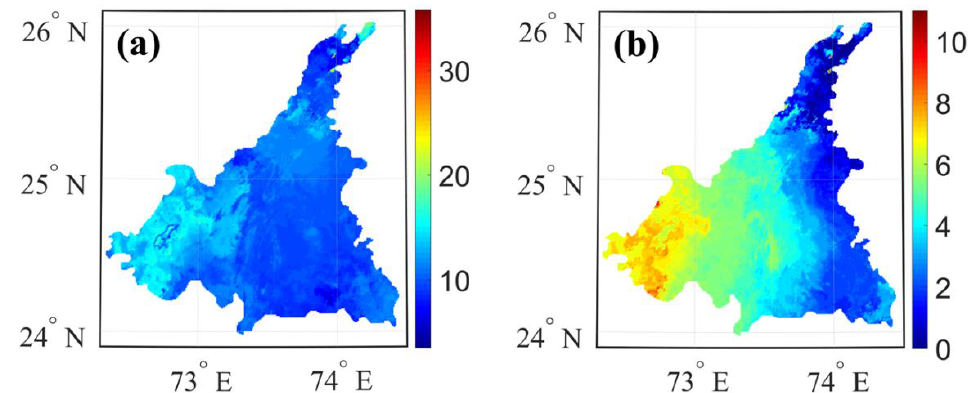
Figure 12. Drought duration maps for historic observed data for study area AV. ( a ) For severe drought and ( b ) for extreme drought. The scale bar represents months of drought in historic 30 years (1985 – 2014).